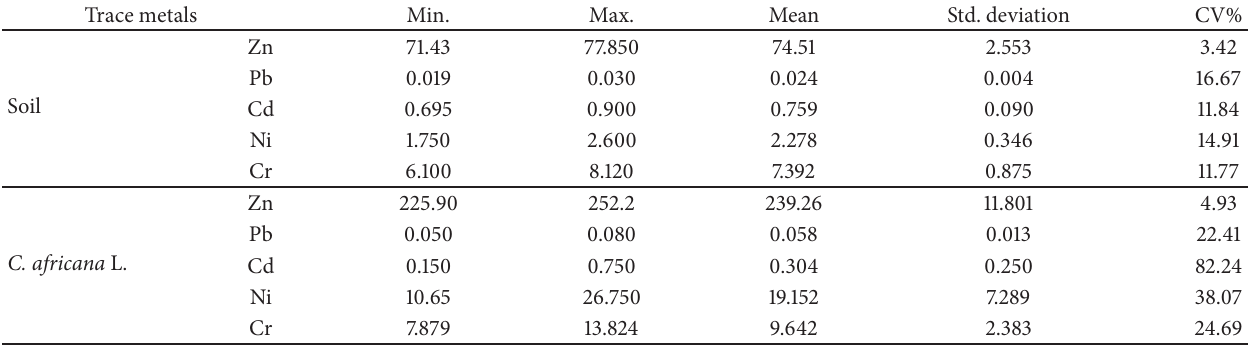
Table 2: Summary statistics of trace metal concentrations(mg/kg) in sandflats and Commelina africana L . from the sandy beachesof Douglas